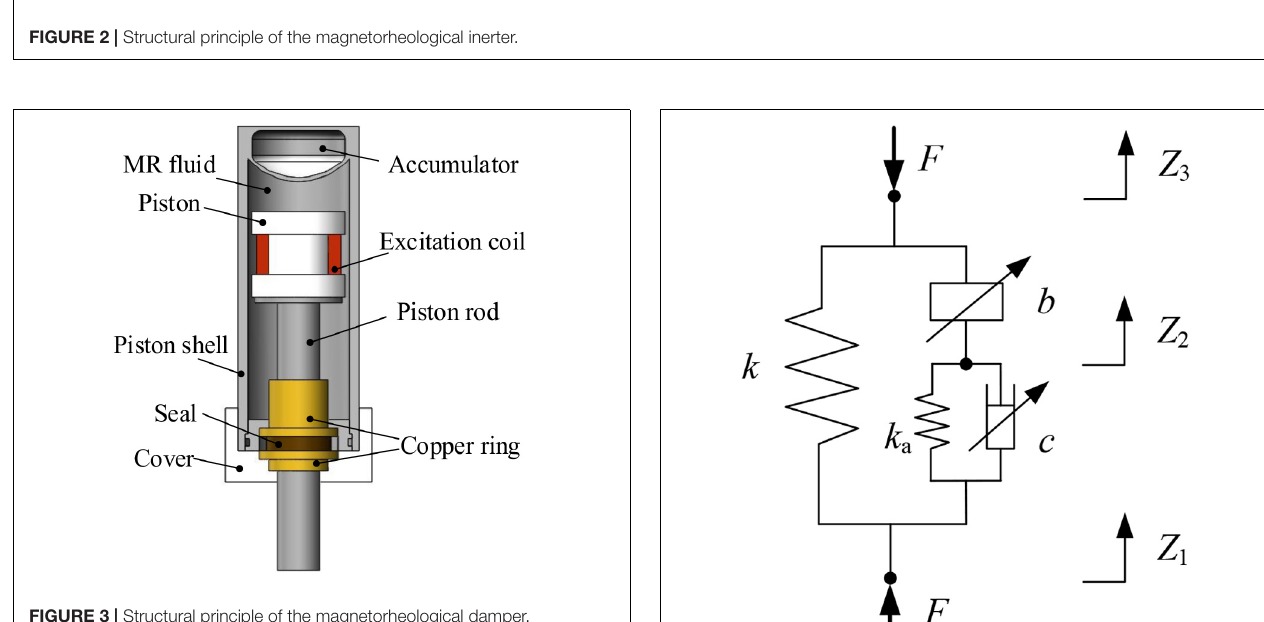
FIGURE 3 | Structural principle of the magnetorheological damper.